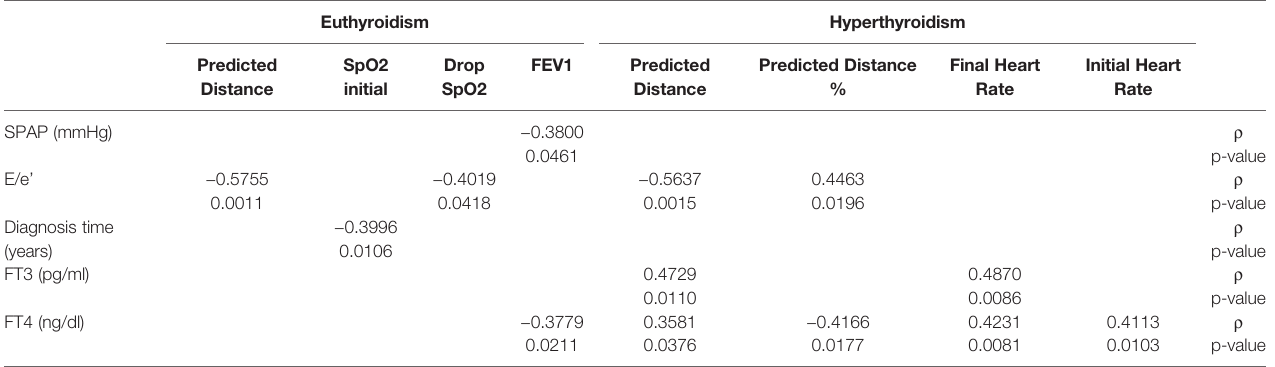
TABLE 6 | Comparative analysis between the parameters used in the respiratory assessment of patients with Graves ’ disease according to the presence of Pulmonary